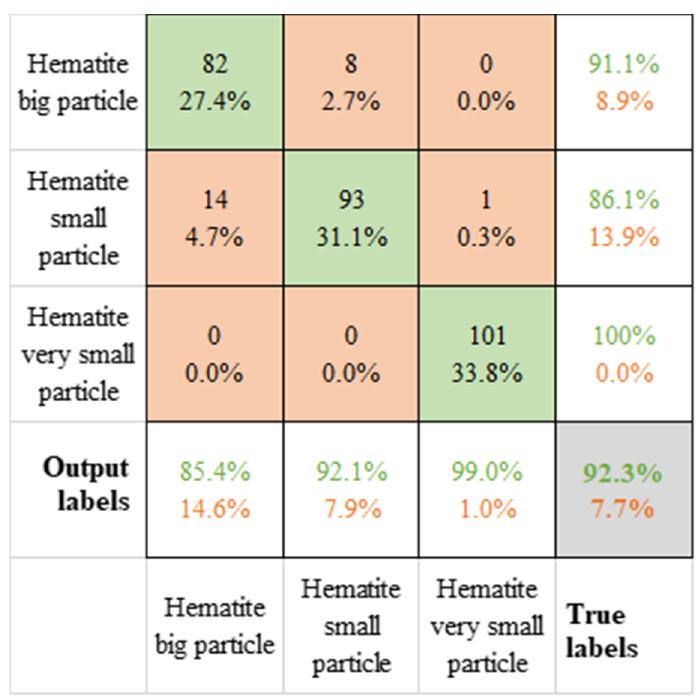
Figure 14. The learning curve of deep learning for three types of minerals. (The horizontal axis shows the iteration and the vertical axis shows the accuracy of classification. The blue line shows the accuracy for the learning data set and the black dots represent the accuracy for the verification data set.).